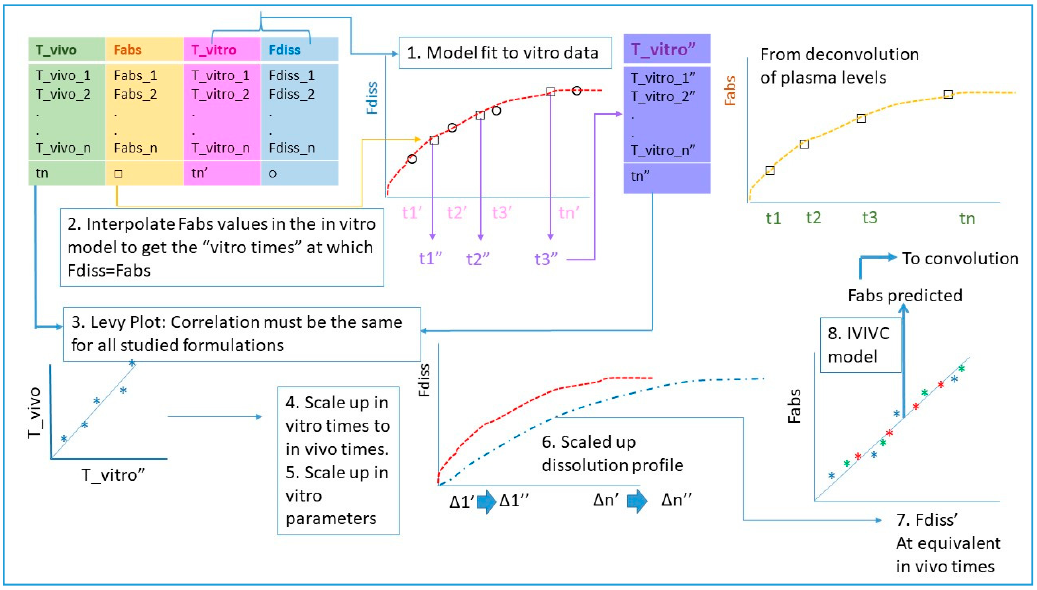
Figure 1. Steps describing the calculations to establish a two-step in vitro–in vivo correlations (IVIVC) when in vivo and in vitro dissolution processes take place at different rate and in consequence the time scale is different.